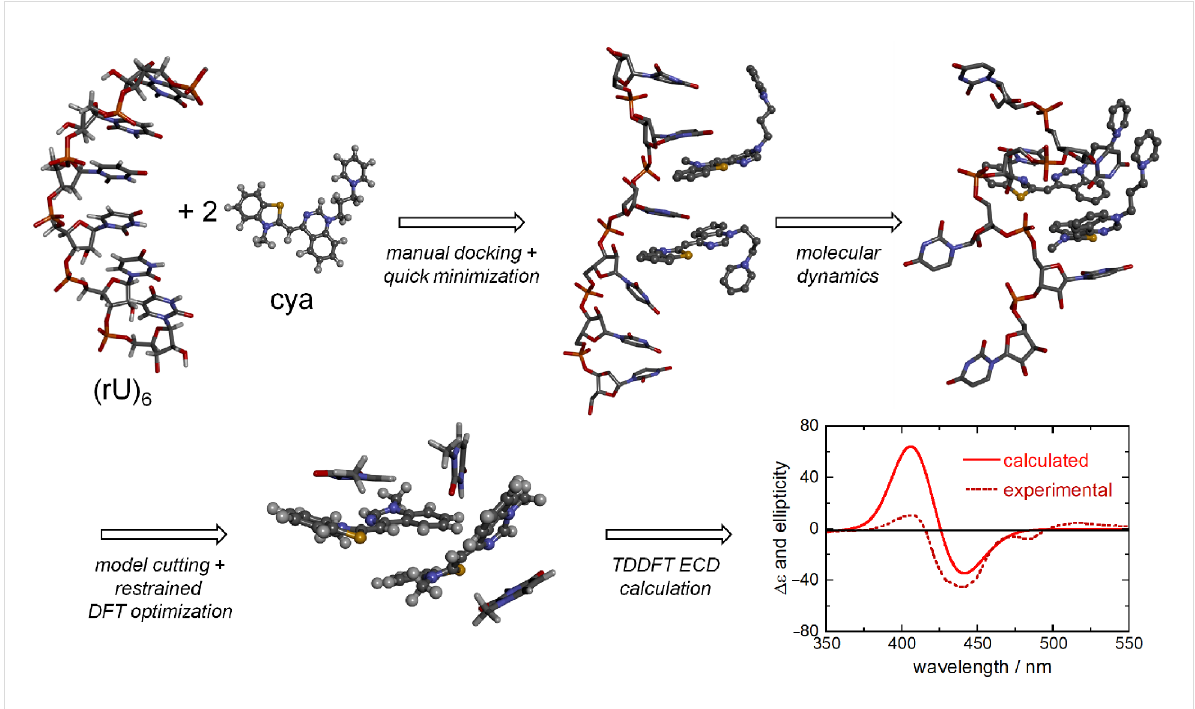
Figure 13: Schematic representation of the main steps for calculating the ICD spectrum of a ligand bound to a single-stranded RNA. In this case, a double binding of cyanine ligands (cya) was expected to occur in two consecutive binding sites. In the final model for ECD calculations, two “cya” mol- ecules and the three closest nucleobases found after MD were considered. The ICD is exciton-like and is dominated by the exciton coupling between the cyanine ligands. Adapted from